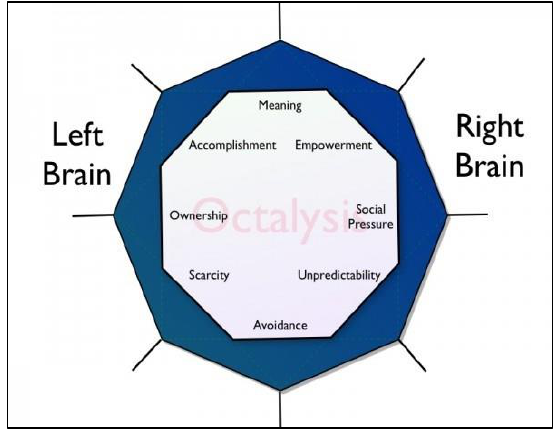
Figure 1 . Left Brain vs. Right Brain Core Drives